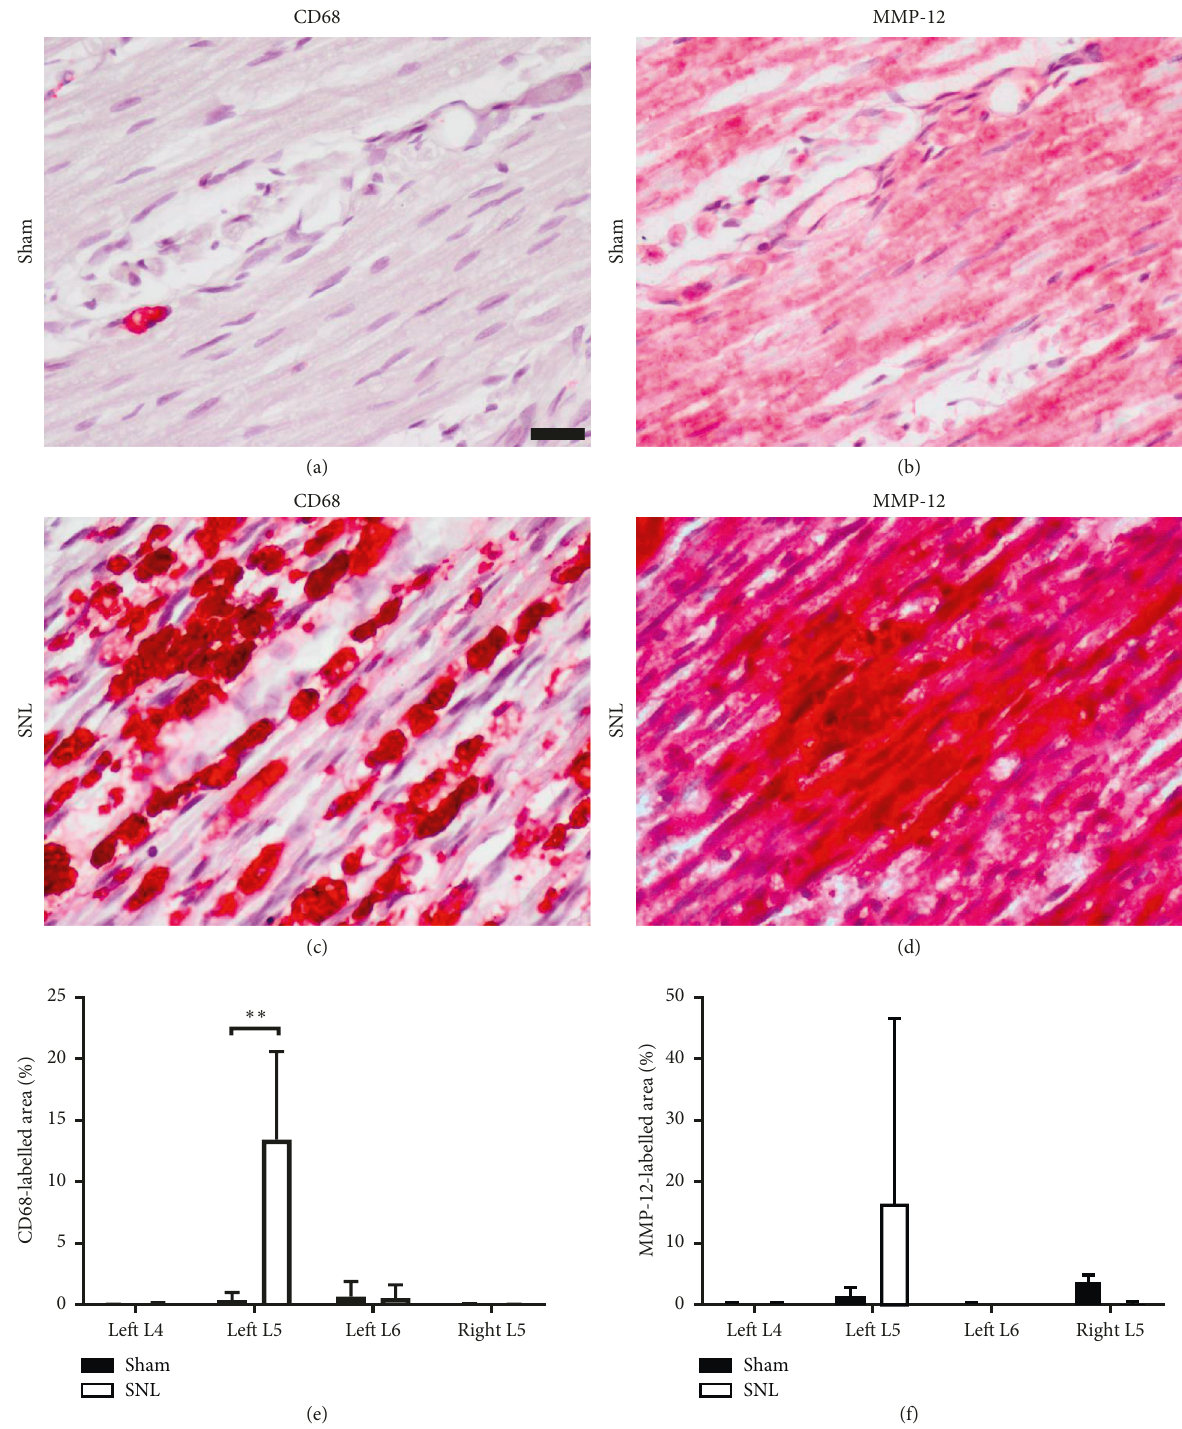
Figure 2: Macrophage infiltration and MMP-12 upregulation occurred in injured nerves. (a–d) Representative images of immunohis- tochemistry staining on consecutive sections for macrophage marker CD68 and MMP-12, in the left L5 spinal nerves distal to the DRG, 1week after SNL or sham surgery (CD68 or MMP-12: red, nuclei: purple, scale bar � 20 μ m). (e) CD68- and (f) MMP-12-labelled areas were quantified for SNL and sham rats’ spinal nerves ( n � 5 per group). Statistically significant difference in the left L5 spinal nerve CD68-labelled area was determined by Mann–Whitney U test ( ∗∗ p < 0 .